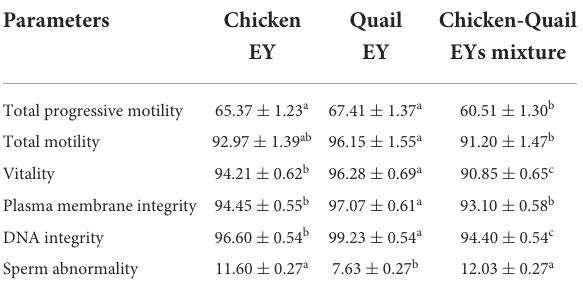
TABLE 3 Effects of adding and combining egg yolks (EY) of chicken and/or quail to the Tris glycerol extender on morphometry of ram sperm before